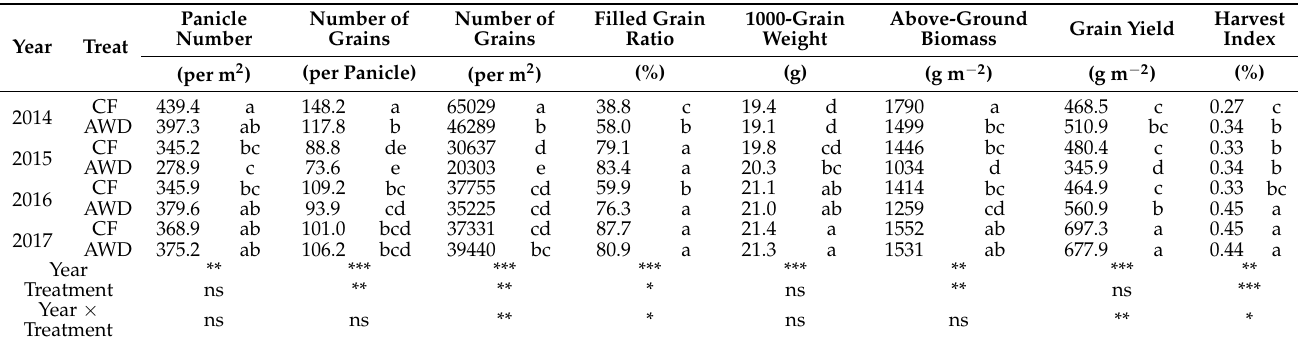
Table 4. Grain yield (g m − 2 ), yield components (panicle number per square meter, number of grains per panicle, number of grains per square meter, filled grain ratio, 1000-grain weight), above-ground biomass, and harvest index of the Basmati 370 plants, grown under continuous flooding (CF) and alternate wetting and drying (AWD) conditions during the 2014, 2015, 2016, and 2017